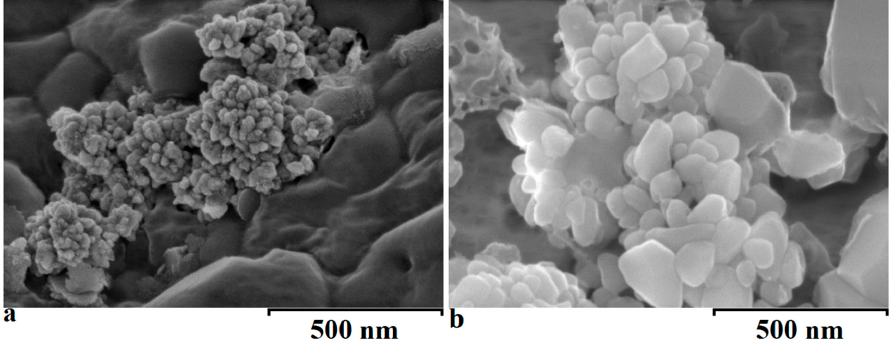
Figure 4. SEM images of copper oxide particles produced either through ( a ) wet mixing process or ( b ) powder mixing process. Magnification is 100.00 k.